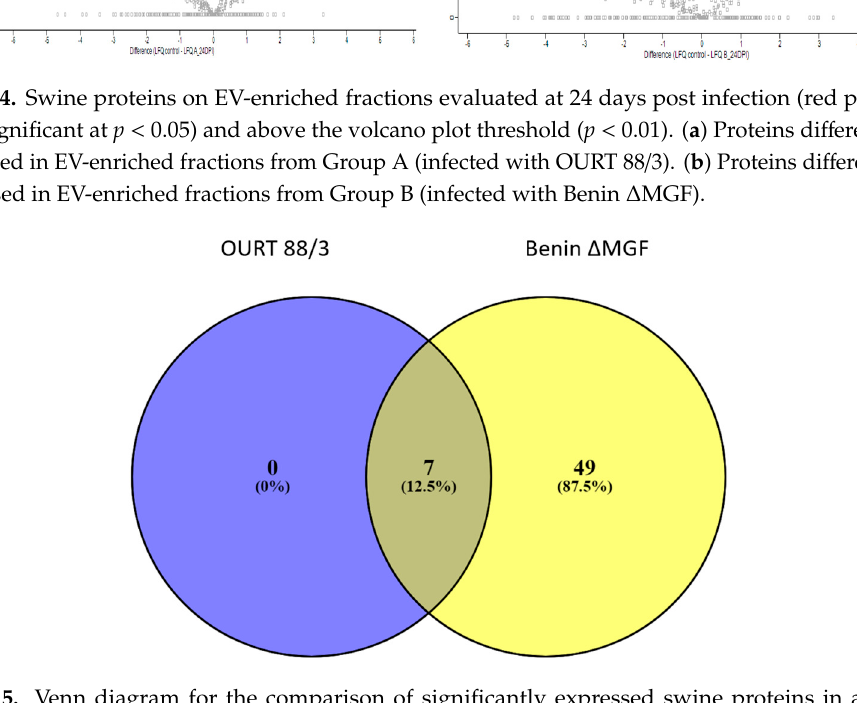
Figure 5. Venn diagram for the comparison of significantly expressed swine proteins in a virus-dependent manner detected in serum-derived EVs.